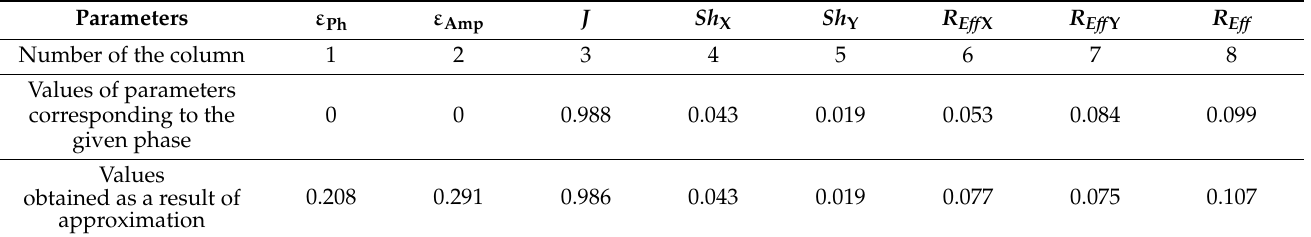
Table 6. Characteristics of the beam in the plane of observations. Parameters of numeric experiment were the same as in the previous example (Figure 14).